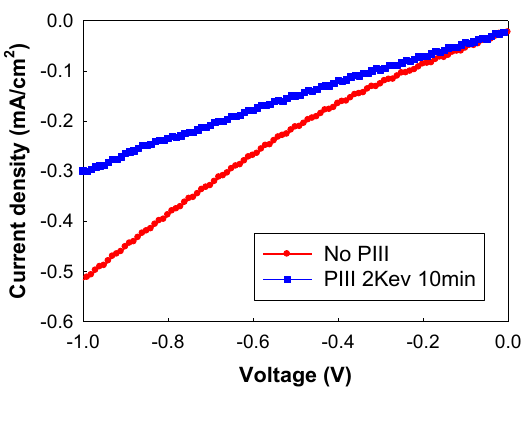
Figure 12. The reverse dark I-V characteristic curve of solar cell (using heterojunction solar cell without AlO x